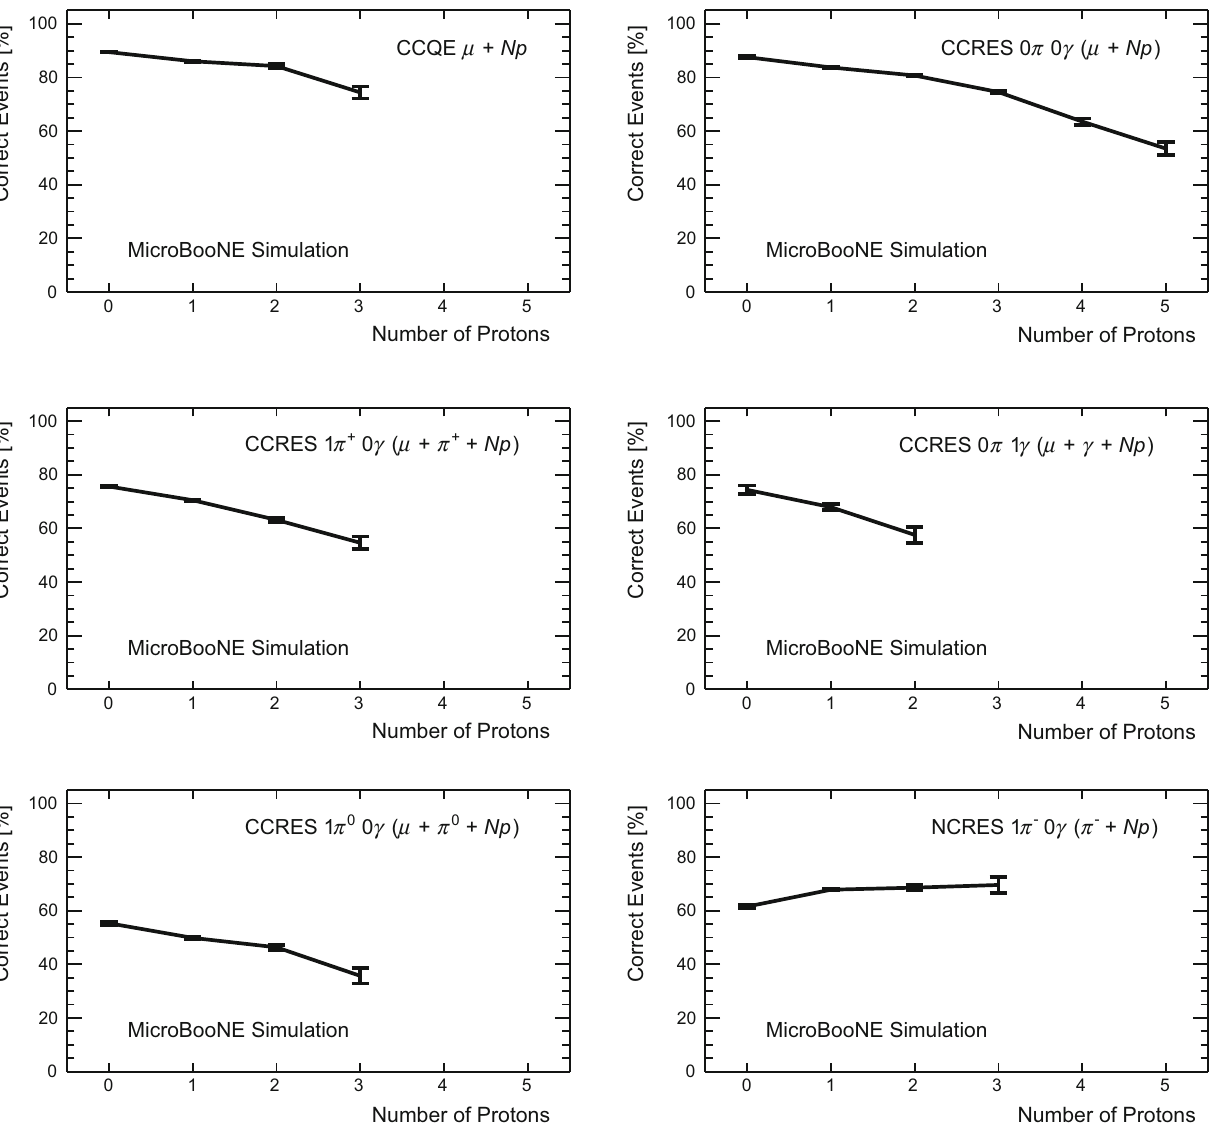
Fig. 20 The fraction of events deemed to have correct pattern recogni- tion, shown for a selection of different BNB interactions with exclusive final states. For each interaction type (and combination of final-state leptons, pions or photons), the correct event fraction is displayed as a